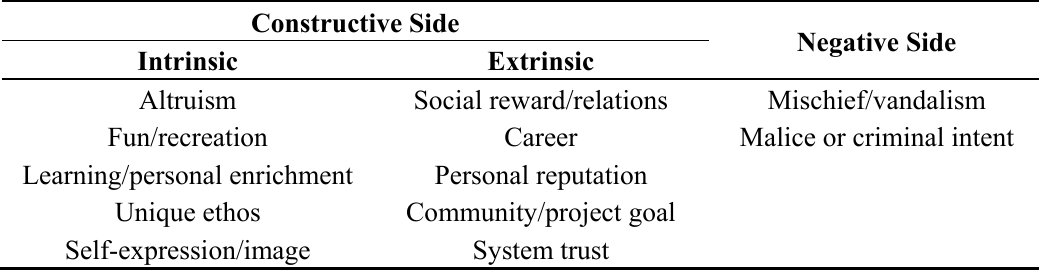
Table 2. VGI motivating factors (paraphrased from Budhathoki [125] and Coleman et al .